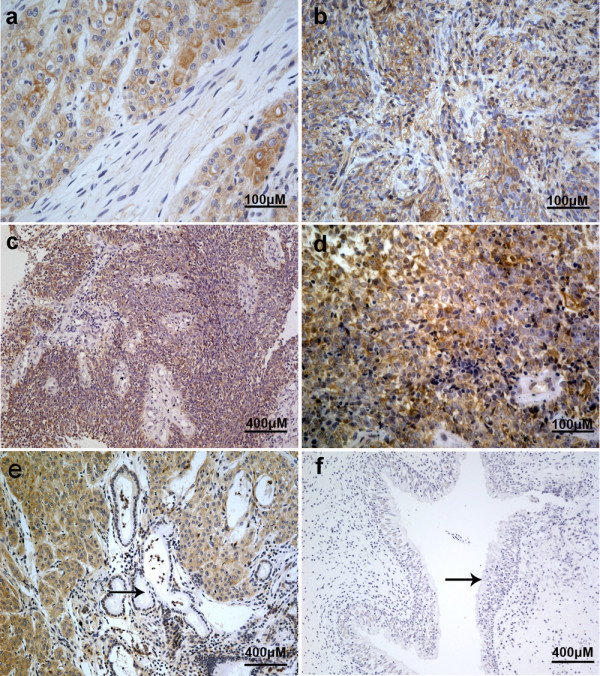
Representative pictures of Cripto-1 expression evaluated by immunohistochemical staining in human NPC samples. (a) and (b) Positive expression of Cripto-1 in WHO type I and III NPC samples (Original magnification ×400). (c) and (d) Positive expression of Cripto-1 in WHO type II NPC samples (Original magnification, ×100 and ×400, respectively). (e) and (f) Negative Cripto-1 staining of residual gland and normal nasopharyngeal epithelial tissue (arrow: residual gland and normal epithelial cells; Original magnification, ×100).